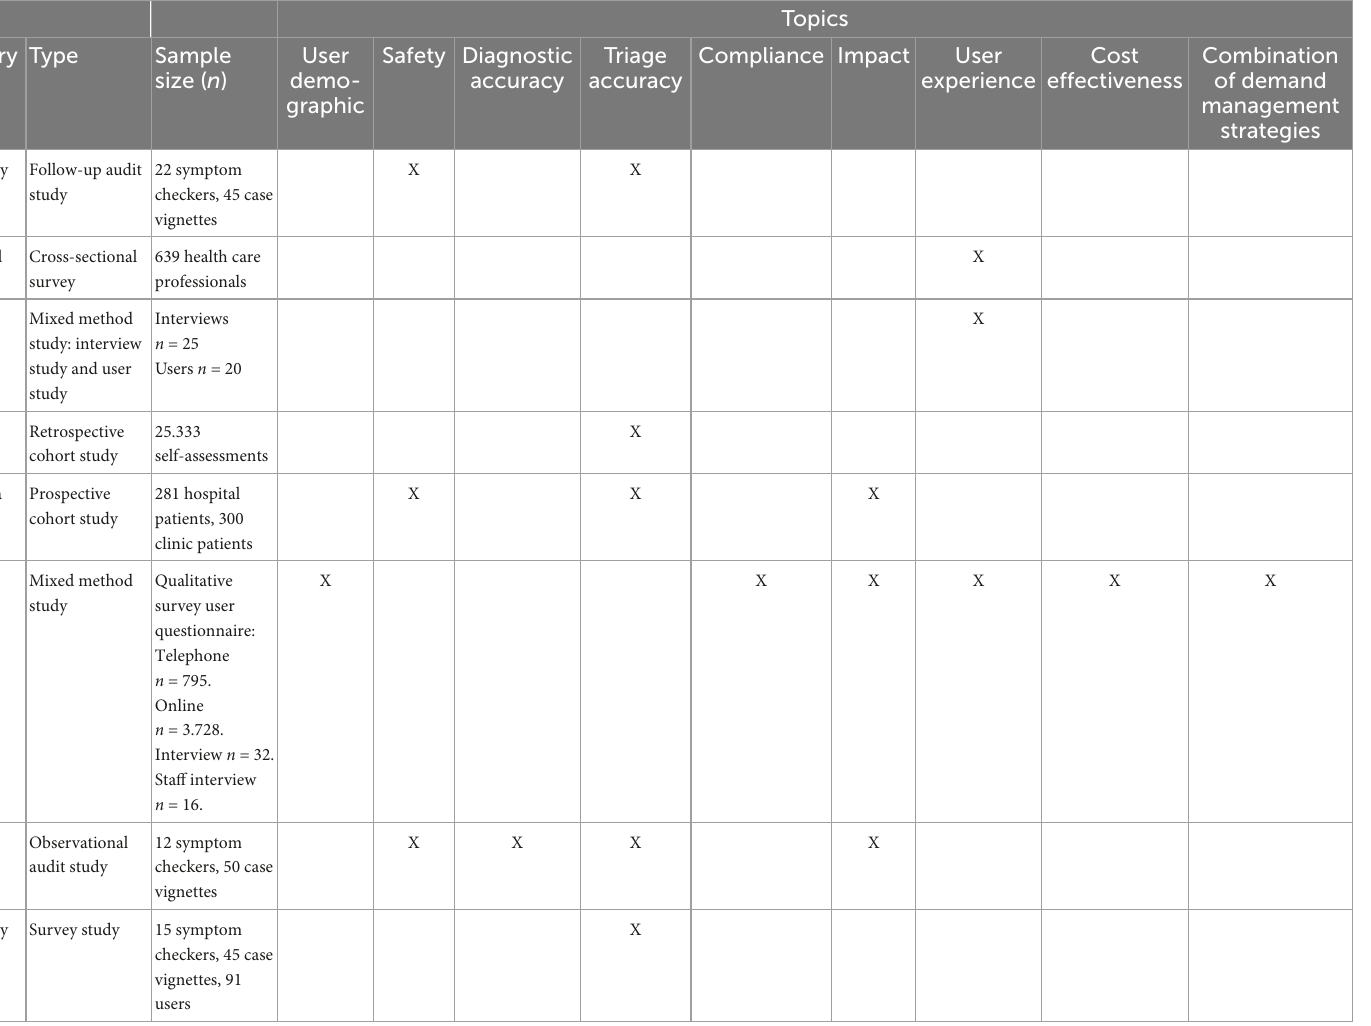
TABLE 1 Included studies of online symptom checkers and triage tools ordered